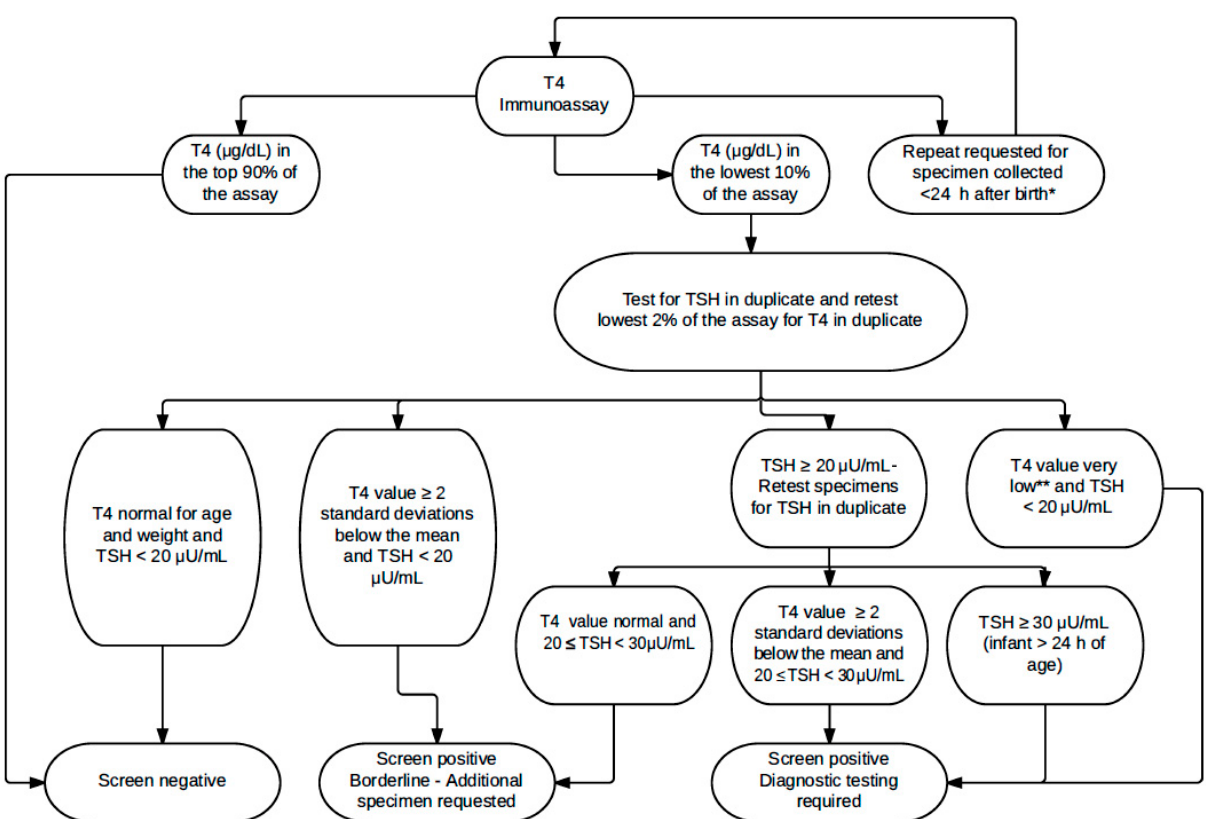
Figure 1. Congenital hypothyroidism testing algorithm in NYS during this study {Adapted from [16]. Copyright (2018), Bioscientifica, Ltd.}. * A repeat specimen is requested when a specimen collected on day of birth (DOB) is received but the specimen is nevertheless tested. ** T4 value very low is 2.5 µ g/dL for an initial specimen in a ≥ 2500 g baby collected at <14 days of age, although the value varies based on birth weight, age at specimen collection, and repeat status. If the TSH value of a DOB specimen is ≥ 150 μ U/mL, the infant is immediately referred to a paediatrician for investigation of probable congenital hypothyroidism (CH). For a non-DOB specimen, an infant with a TSH value ≥ 100 μ U/mL is immediately referred. T4, thyroxine; TSH, thyroid-stimulating hor- mone.